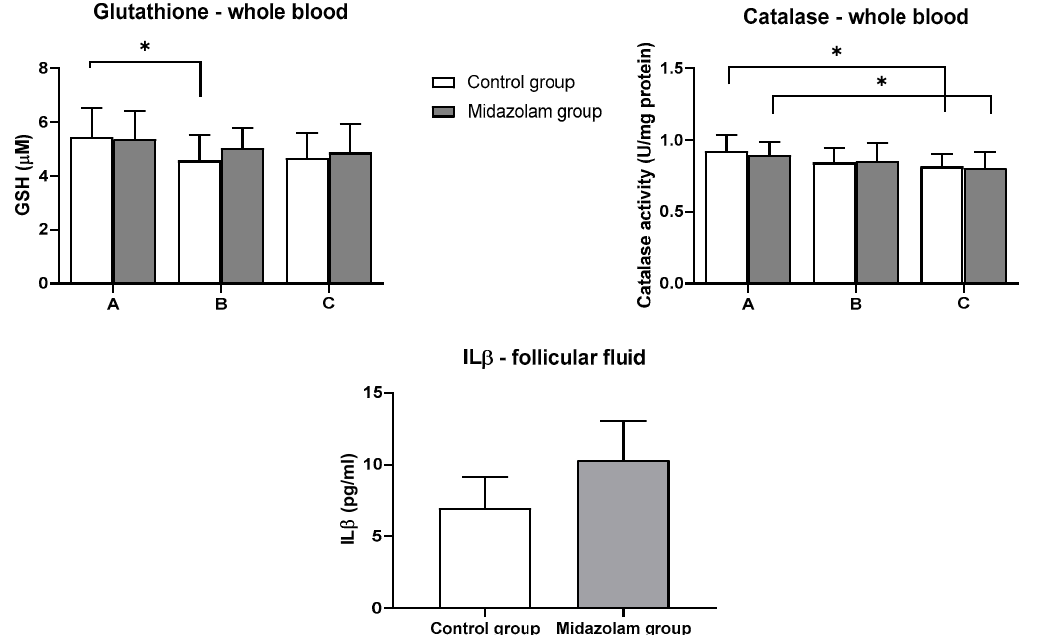
Figure 2. Levels of GSH and catalase activity in whole blood and levels of IL β in the follicular fluid. Blood samples of each patient were collected at the acceptance to hospital (time point A), prior to oocyte retrieval (time point B), and 2 h after the procedure (time point C). Values represent mean ± SE; * p < 0.05.